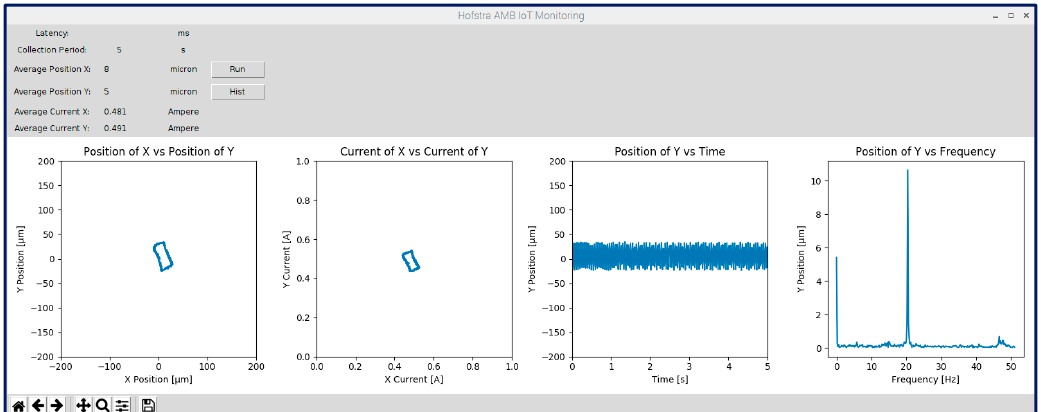
Figure 8. AMB IoT condition monitoring GUI display for rotating bare shaft.